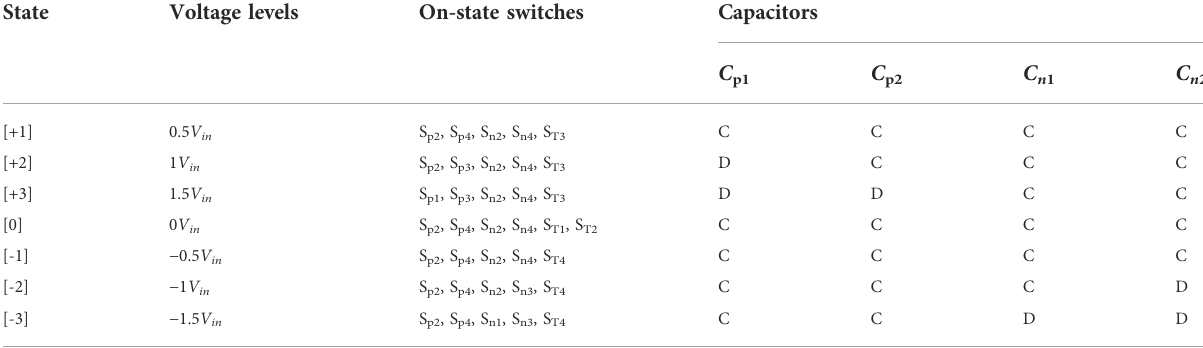
TABLE 1 Switching states for the proposed seven-level